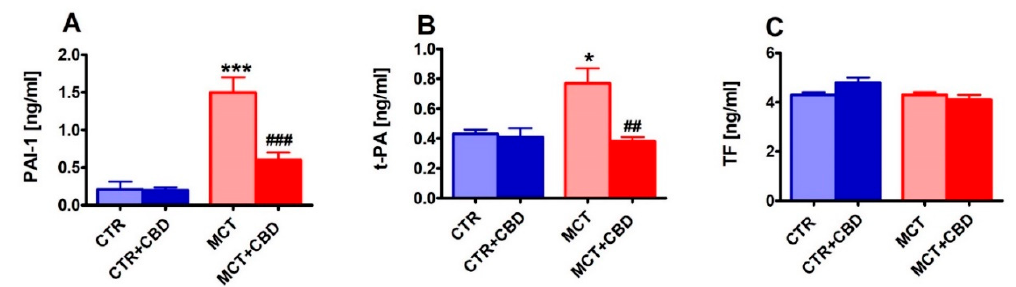
Figure 5. The effect of chronic administration of cannabidiol (CBD) on plasma hemostasis parameters (plasminogen activator inhibitor type 1, PAI-1 ( A ); tissue plasminogen activator t-PA ( B ); tissue factor, TF ( C )) in control (CTR) and monocrotaline (MCT)-induced pulmonary hypertension. CBD 10 mg/kg or its vehicle were injected intraperitoneally every 24 h for 21 days. Data are presented as mean ± SEM, ( n = 6–8 per group); * p < 0.05, ## p < 0.01, *** , ### p < 0.001 compared to the respective group (* CTR, # MCT group).